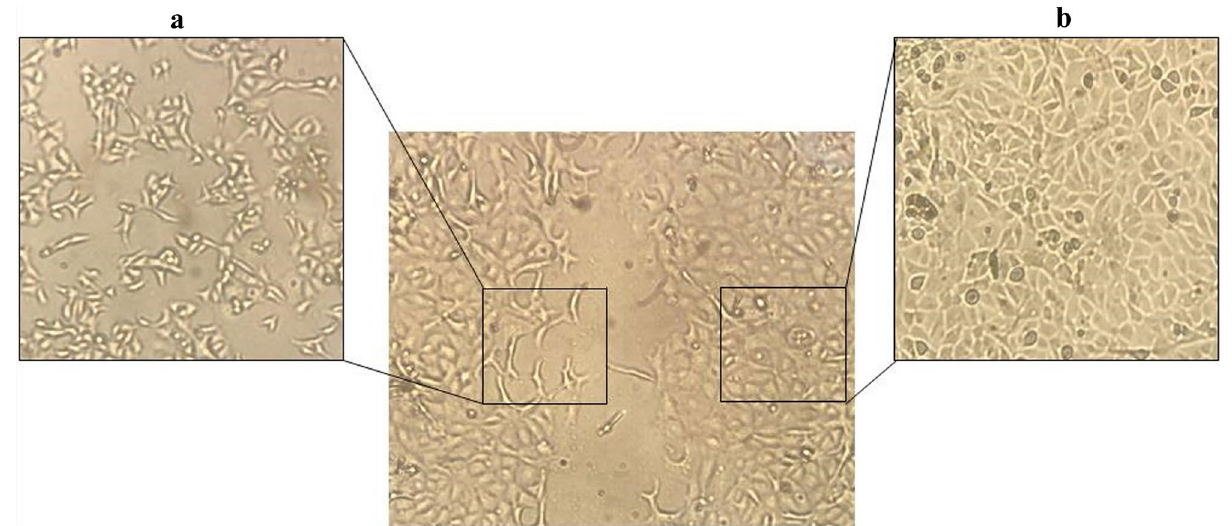
Figure 7. Invert microscopy identifies morphological changes induced in ESCC lines by EZH2 at 48 h. ( a ) Epithelial morphology. ( b ) Mesenchymal